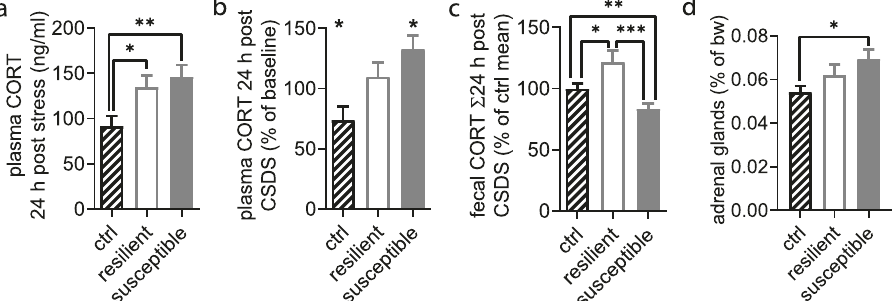
Fig. 2 Multimodal HPA axis response after CSDS discriminates stress phenotypes. a Plasma corticosterone (CORT) levels were increased 24 h post CSDS (F 2,42 = 5.954, P = 0.005, one-way ANOVA with Holm-Sidak ’ s post-hoc test); ctrl n = 19, resilient n = 12, susceptible n = 14. b Post-stress plasma CORT changed signi fi cantly relative to baseline (dashed line) as tested by one sample t -tests in controls (t 13 = 2.365, P = 0.034) and susceptible mice (t 8 = 3.063, P = 0.016) but not in resilient ones (t 9 = 0.843, P = 0.421); ctrl n = 14, resilient n = 10, susceptible n = 9. c Fecal CORT re fl ects cumulative release 24 h after CSDS and was signi fi cantly different between stressed phenotypes and stressed vs. control mice (F 2,41 = 7.897, P = 0.001, one-way ANOVA with Holm-Sidak ’ s post-hoc test); ctrl n = 20, resilient n = 12, susceptible n = 12 mice. d Adrenal gland weight measured 36 days post CSDS was signi fi cantly higher in the susceptible mice compared to controls and resilient mice (F 2,41 = 4.580, P = 0.016, one-way ANOVA with Holm-Sidak ’ s post-hoc test); ctrl n = 19, resilient n = 12, susceptible n = 14 mice. * P < 0.05, ** P < 0.01, *** P < 0.001. Results are shown as mean ±